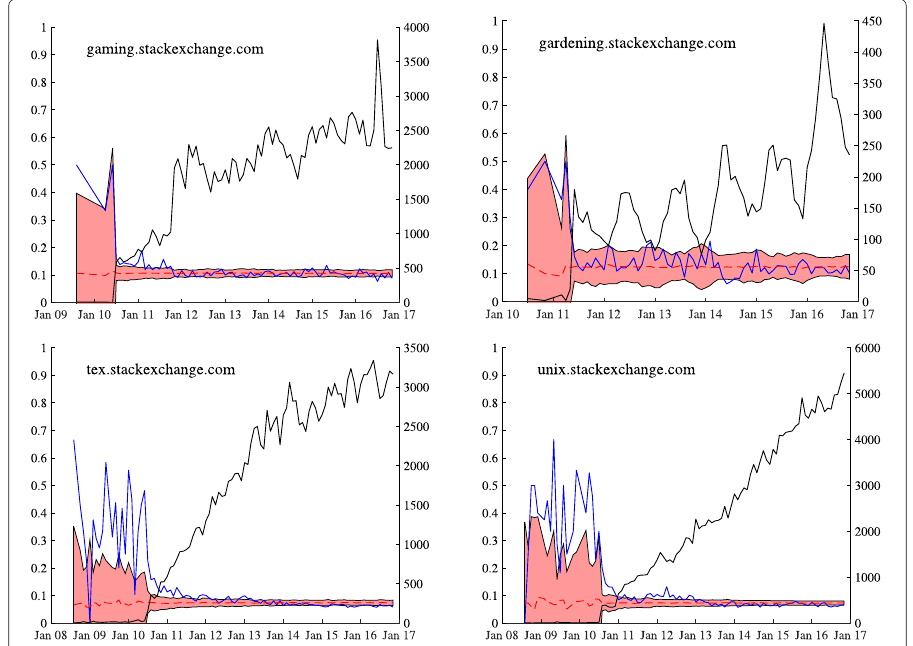
Fig. 8 Behaviour of γ R in graphon models of different communities. Blue line: real γ R ; red dashed line: average γ R over 100 sampled communities; red shading: area two standard deviations above and below the average γ R ; black line: community size (scale on the